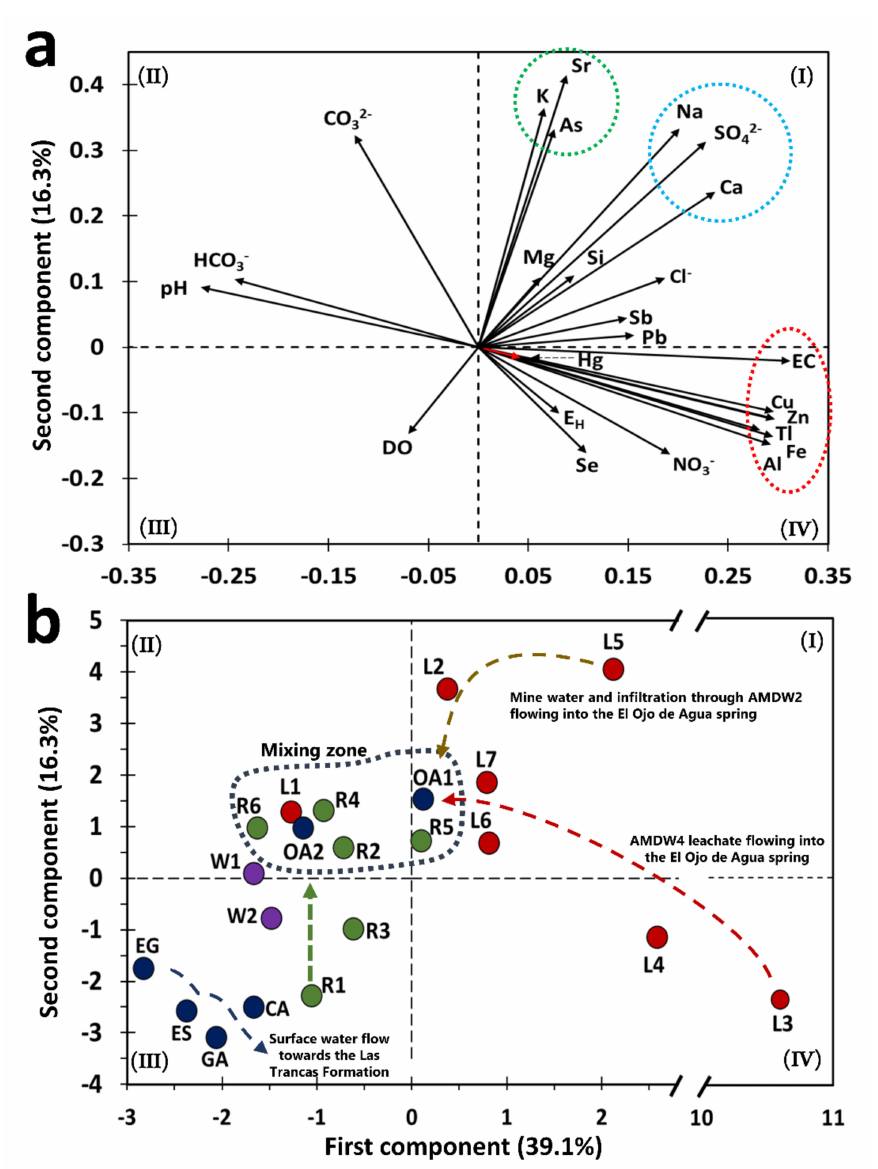
Figure 3. Principal component analysis for the water samples collected in the study area. ( a ) Eigen- vector of the variables considered in the PCA. ( b ) Projection of the leachate samples (red circle), wells (purple circle), rivers (green circle), and springs (blue